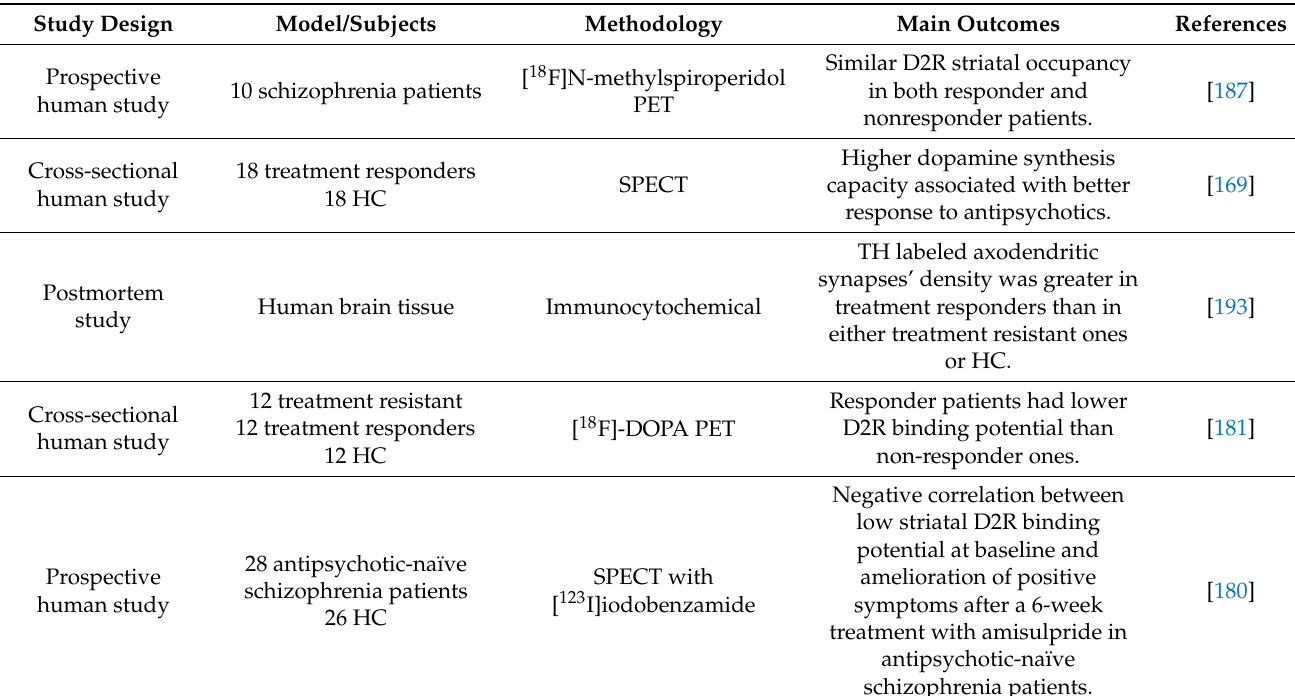
Table 5. Comparison of treatment resistant and treatment responder patients/preclinical paradigms evaluating presynaptic dopamine-related biological mechanisms of non-response to